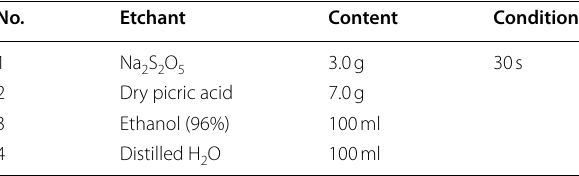
Table 5 Final composition of LePera solution